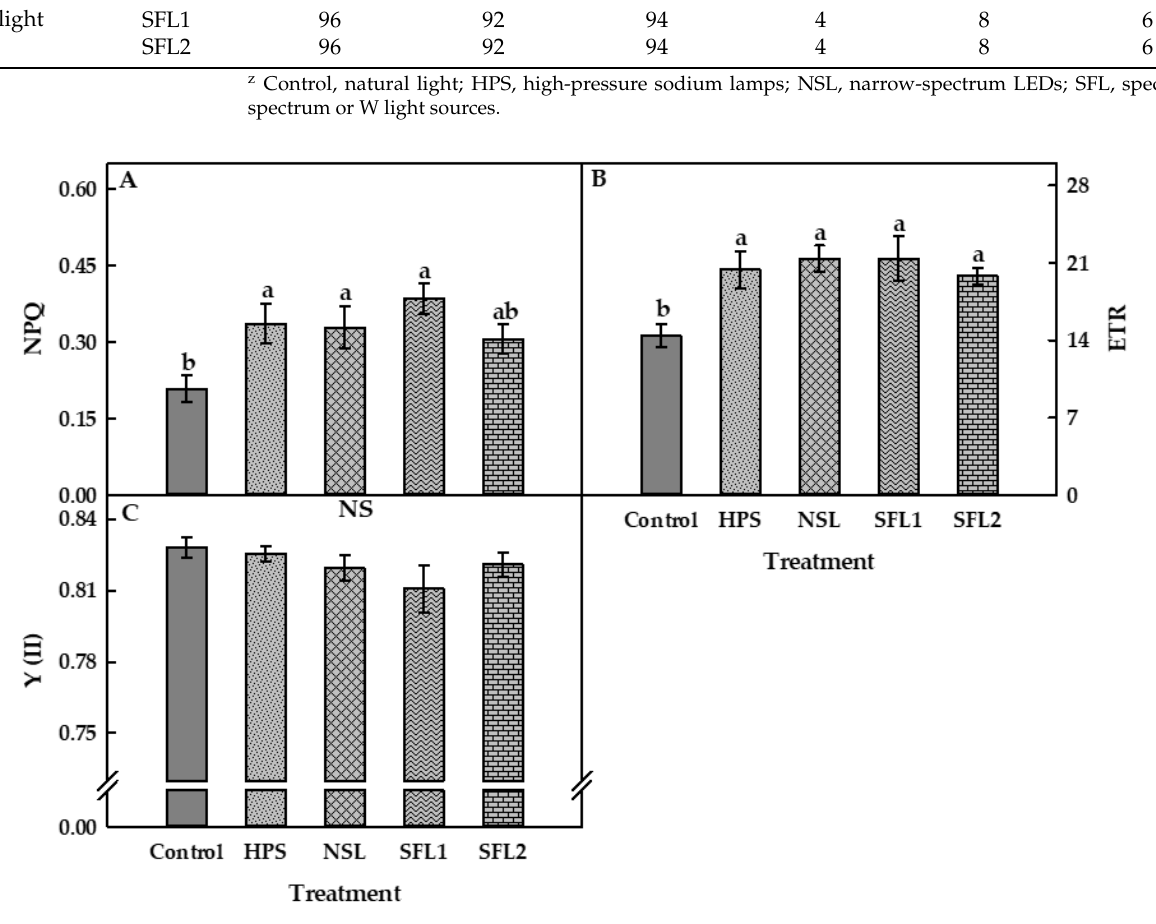
Figure 3. NPQ ( A ), ETR ( B ), and Y (II) ( C ) of cherry tomato plants grown with different SL sources after 7 weeks of treatment. Control, natural light; HPS, high-pressure sodium lamps; NSL, narrow- spectrum LEDs; SFL, specific full-spectrum or W light sources. Different letters above the bars indicate a significant difference at p < 0.05 ( n = 5). NS; not